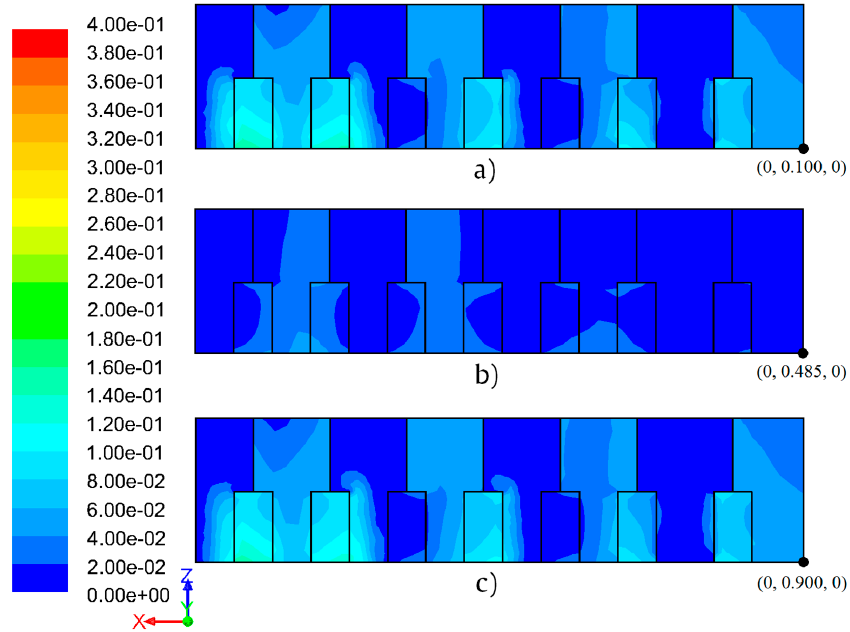
Figure 19. The results of the field of temperature in the x–z plane through the planes: ( a ) y adm = 0.100; ( b ) y adm = 0.485; and ( c ) y adm = 0.900.